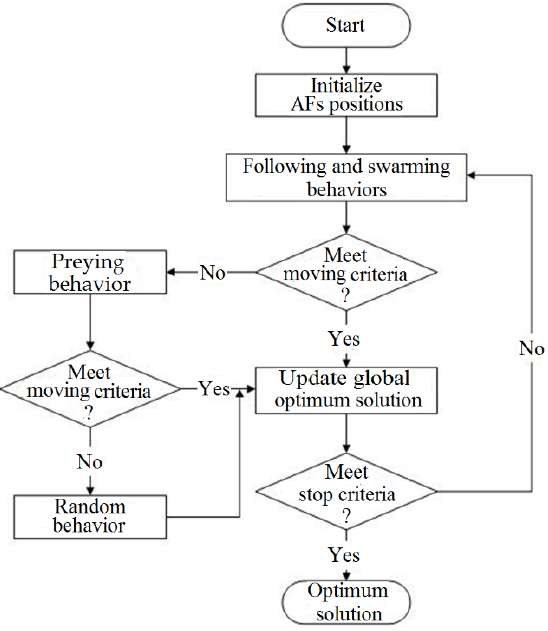
Figure 3. F low chart of AFSA. Figure 3. Flow chart of